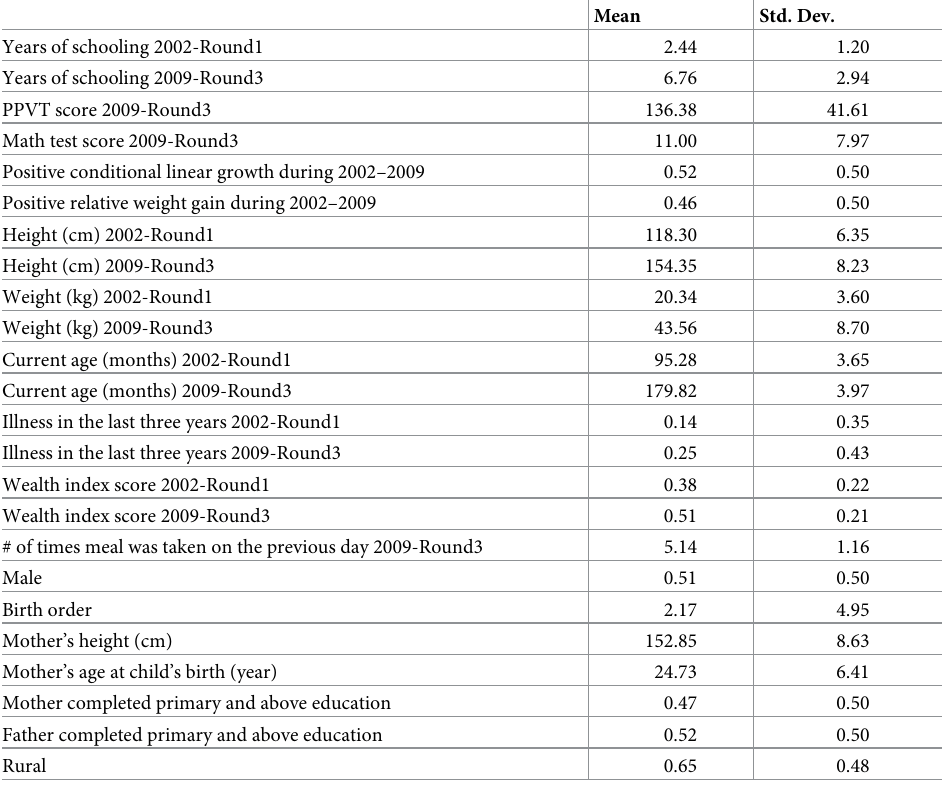
Table 1. Descriptive statistics of educational outcome measures and exposure variables (N =